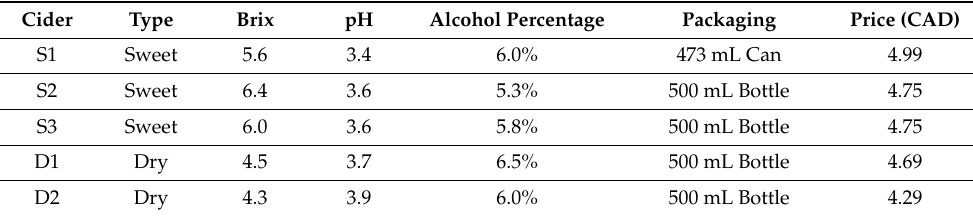
Table 1. Physico-chemical and market characteristics of the ciders